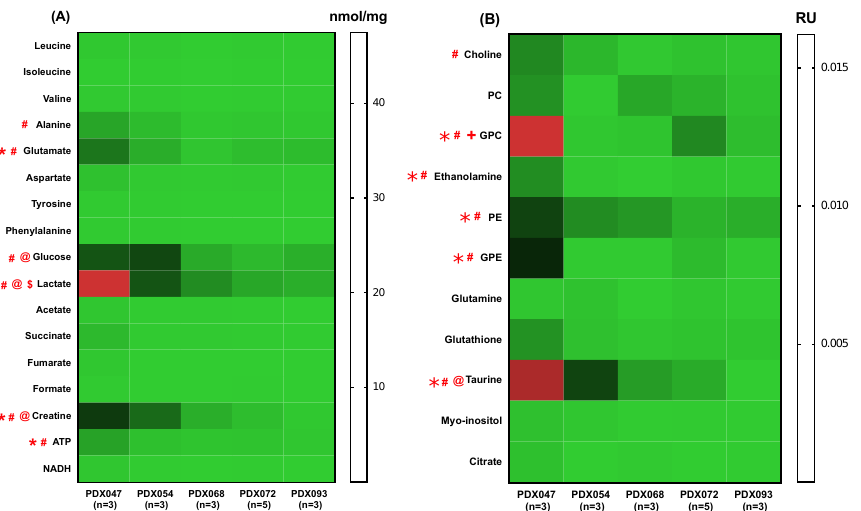
Figure 5. Heat maps showing ( A ) absolute concentrations (nmol/mg) and ( B ) concentrations relative to TSP (RU) of steady state metabolite levels among PDX. *: p < 0.05, PDX047 and PDX054, #: p <